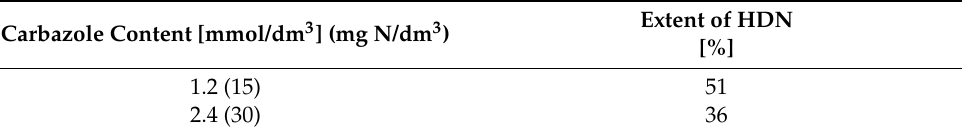
Table 1. The extent of HDN at a reactor temperature of 300 ◦ C with different carbazole content in the reactant